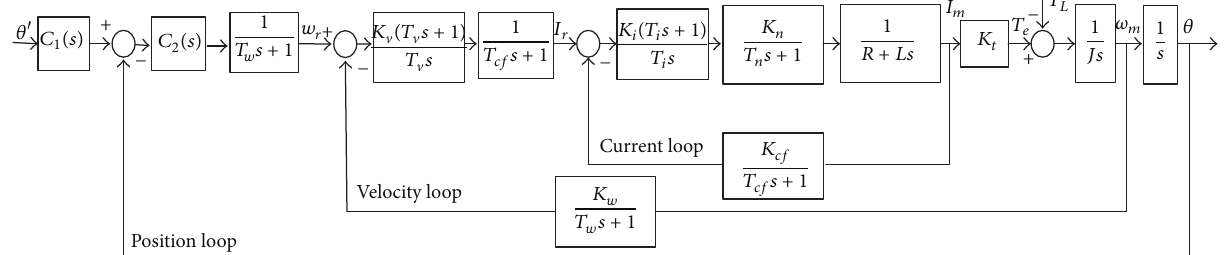
Figure 2: Block diagram of three control loops.